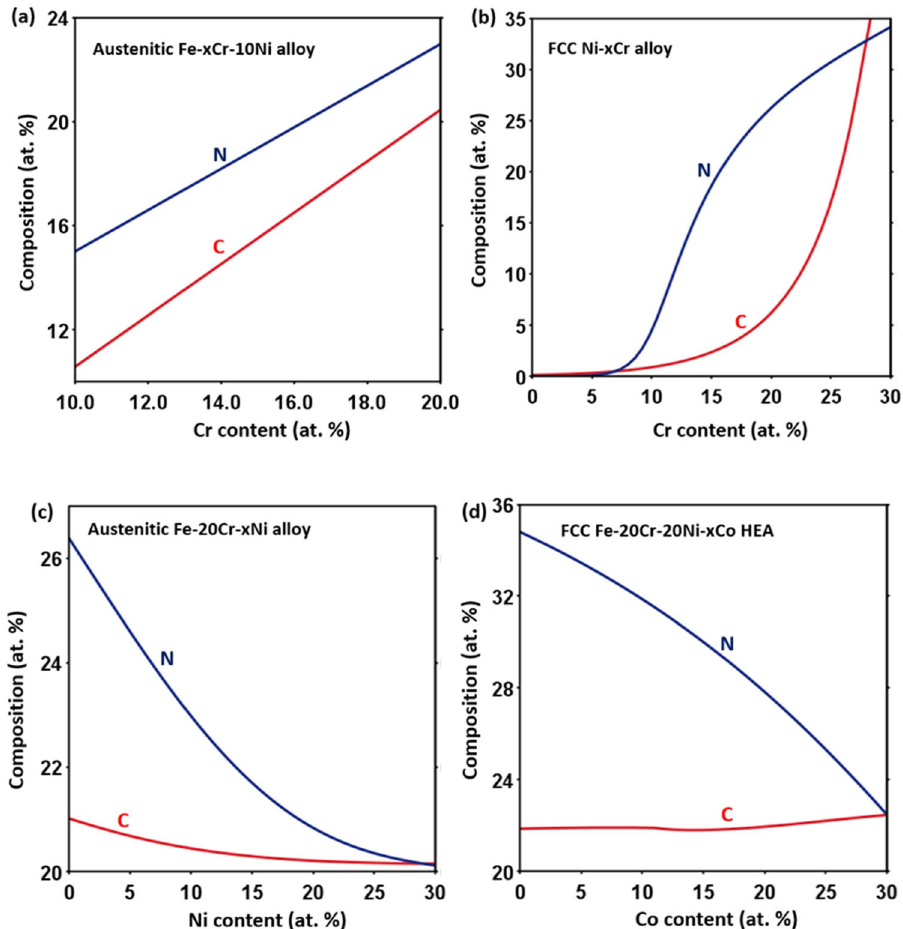
Fig. 6 Maximum allowed metastable N or C supersaturation by suppressing nitrides/carbides in different alloys (with compositions in at. %). a Austenitic Fe-xCr-10Ni alloy. b FCC Ni-xCr alloy. c Austenitic Fe-20Cr-xNi alloy. d FCC Fe-20Cr-20Ni-xCo high entropy alloy. Calculated for typical nitriding/carburization conditions at 450 °C using N activity of 3 × 10 − 4 and C activity of 1 (with respect to standard element reference state (SER)). Commercially available thermodynamic databases (TCFE11 for steels and TCHEA4 for other alloys) along with the Thermo-Calc v. 2021(b) software package have been used for the